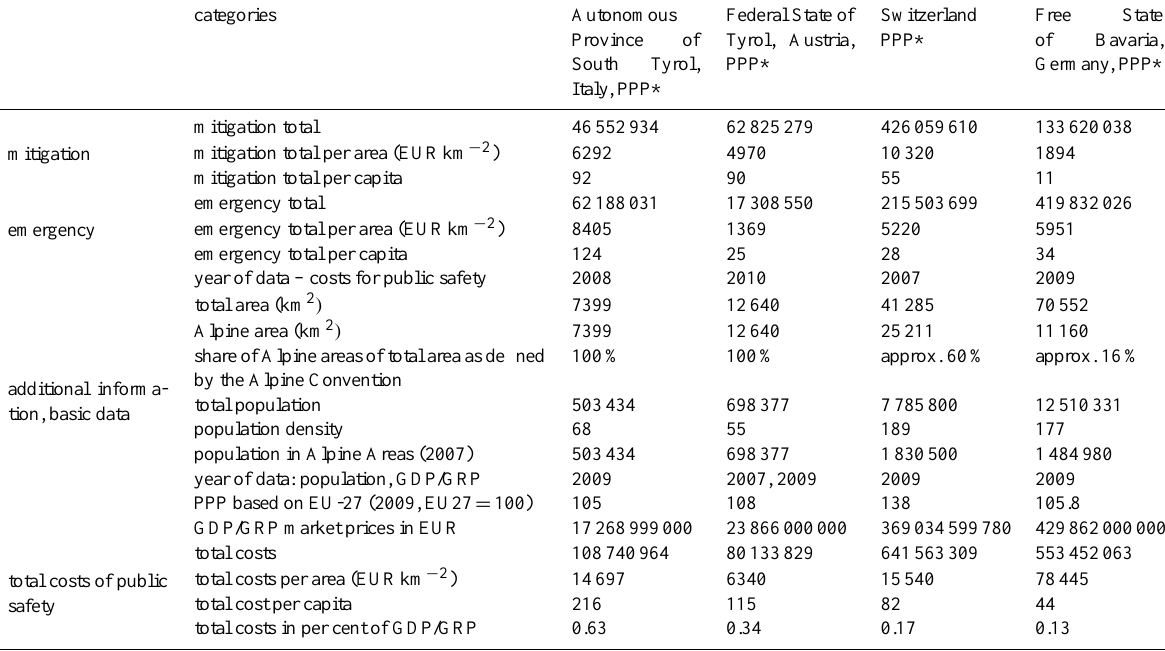
Table 3. Overview of the fixed annual costs of public safety in the case of Alpine hazards in South Tyrol, Tyrol, Switzerland, and Bavaria in EUR PPP values, sources: see Appendix